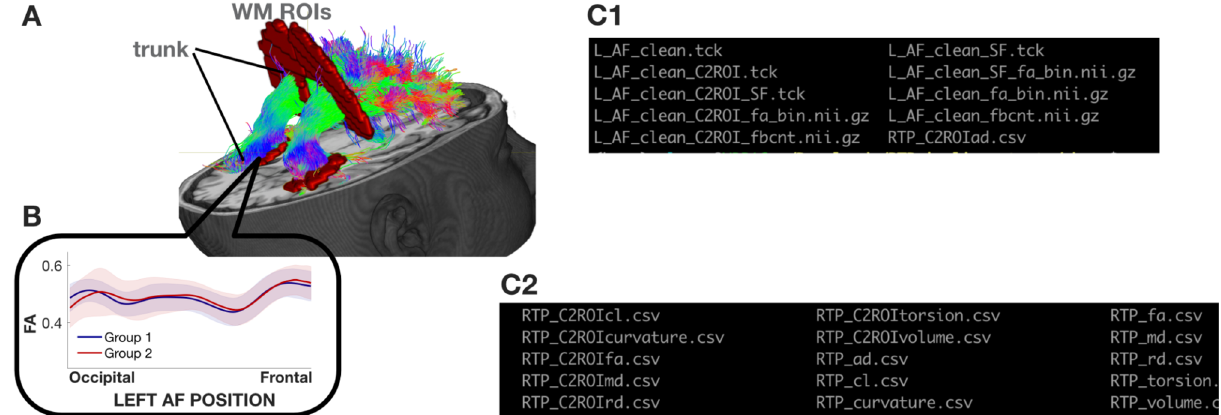
Figure 5. Illustrative tract (arcuate fasciculus) with defining ROIs and tract profile. ( A ) The streamlines serve as a model of white matter tracts; they are selected by fitting to the diffusion-weighted imaging (DWI) measurements. The tracts are defined by regions of interest (ROIs, red) that select specific streamlines from the whole brain tractogram (in this example). The region between the two ROIs is relatively stable and called the trunk. ( B ) Tract’s FA profile. We can calculate profiles from the whole tract or only the trunk, called clip-to-roi (C2ROI) operation. We estimate a core fiber (called super fiber—SF) from the collection of streamlines and sample 100 equally spaced segments. The FA of the core fiber is calculated by combining FA transverse to the core fiber at every sample point, using a Gaussian weighting scheme over distance. The set of sample points is the tract profile; the average of the FA values of the core fiber is the mean tract FA. In the inset, an illustrative example of two group profiles. The dark outline is the mean of the groups, and the shaded outline represents one standard deviation around these values. The plots are generated with Matlab scripts created by reading the csv file values described in ( C 2). ( C 1) List of files in the output of the RTP2-pipeline. Every tract generates a number of different outputs, for both the C2ROI and normal options. Tck files are tract definitions, and they can be the full tract or only the super-fiber (marked as _SF). On top of the tck-s, we created two types of Nifties, the fa_bin Nifti is a mask of the tract, with 1-s where there are fibers and 0-s elsewhere. In the fbcnt Nifti it is zero where there are no fibers, and in the rest of the voxels the value is the fiber count in the voxel. ( C 2) The csv files